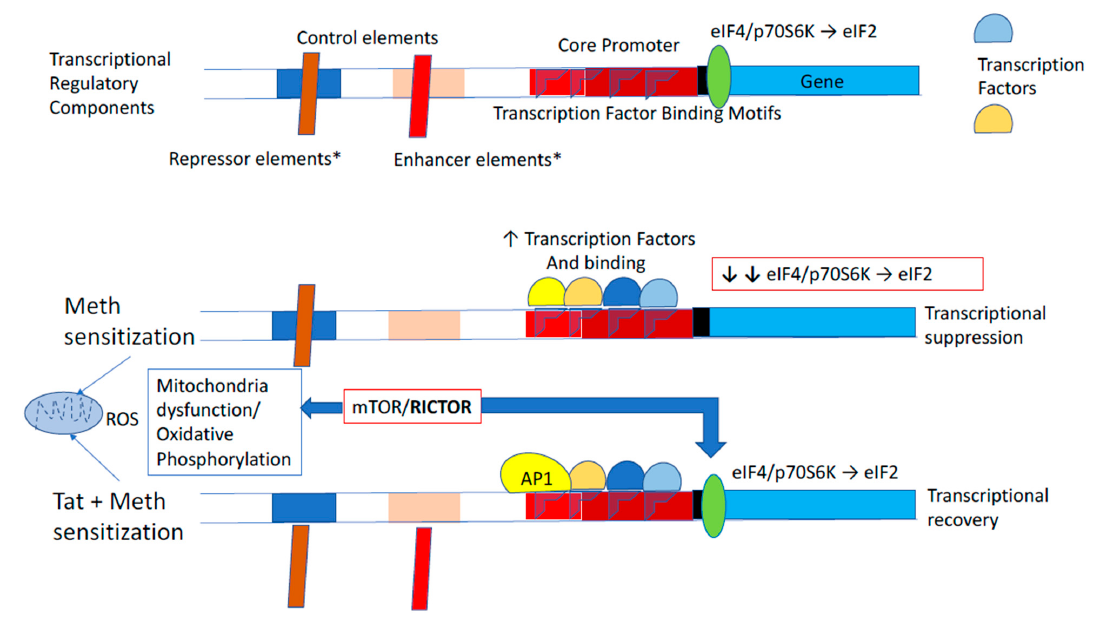
Figure 10. Summary figure of the systems biology-generated hypothesis. Studies on transcriptional patterns, pathway analysis, and transcription factor usage predictions in the brain of Tat-transgenic mice sensitized with Meth suggest the following: Both Meth sensitization alone, and along with the induction of HIV Tat protein, activate transcriptional regulatory mechanisms a ff ecting the same genes but in opposite ways. Overlapping transcriptional factor usage between these two conditions are predicted and could be further regulated by di ff erential actions on transcriptional control elements outside the core promoter, as well as levels of transcription and translation initiation factors (eIF2 and eIF4). These di ff erences can be orchestrated by pathways in the mitochondria, including production of reactive oxygen species (ROS) contributing to changes in oxidative phosphorylation, with mTOR / RICTOR complex as a central regulator, and with AP1 support. We disclose that this concept was generated by a systems biology analytical strategy, and further experiments are